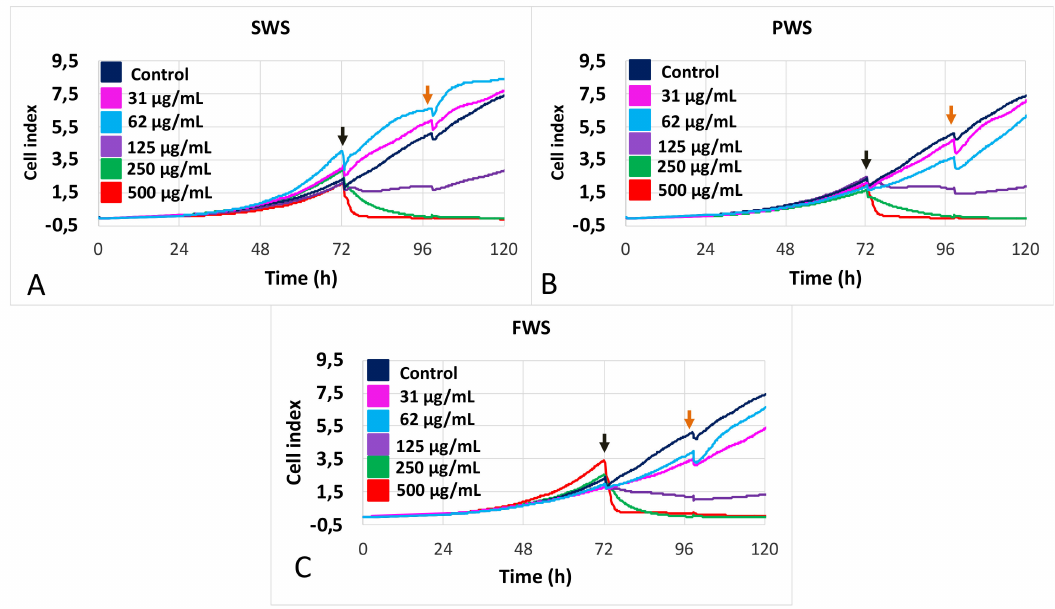
Figure 1. Dose–response curves of A549 cell proliferation in response to stimulations by increasing concentrations of water-soluble particulate pollutants from biomass burning obtained for various burning conditions: ( A ): smoldering (SWS); ( B ): pyrolysis (PWS); and ( C ): flaming (FWS). Color code: dark blue: control, pink: 31 µ g/mL; light blue: 62 µ g/mL; purple: 125 µ g/mL; green: 250 µ g/mL; and red: 500 µ g/mL. Black arrows indicate time of treatment addition; orange arrows indicate time of